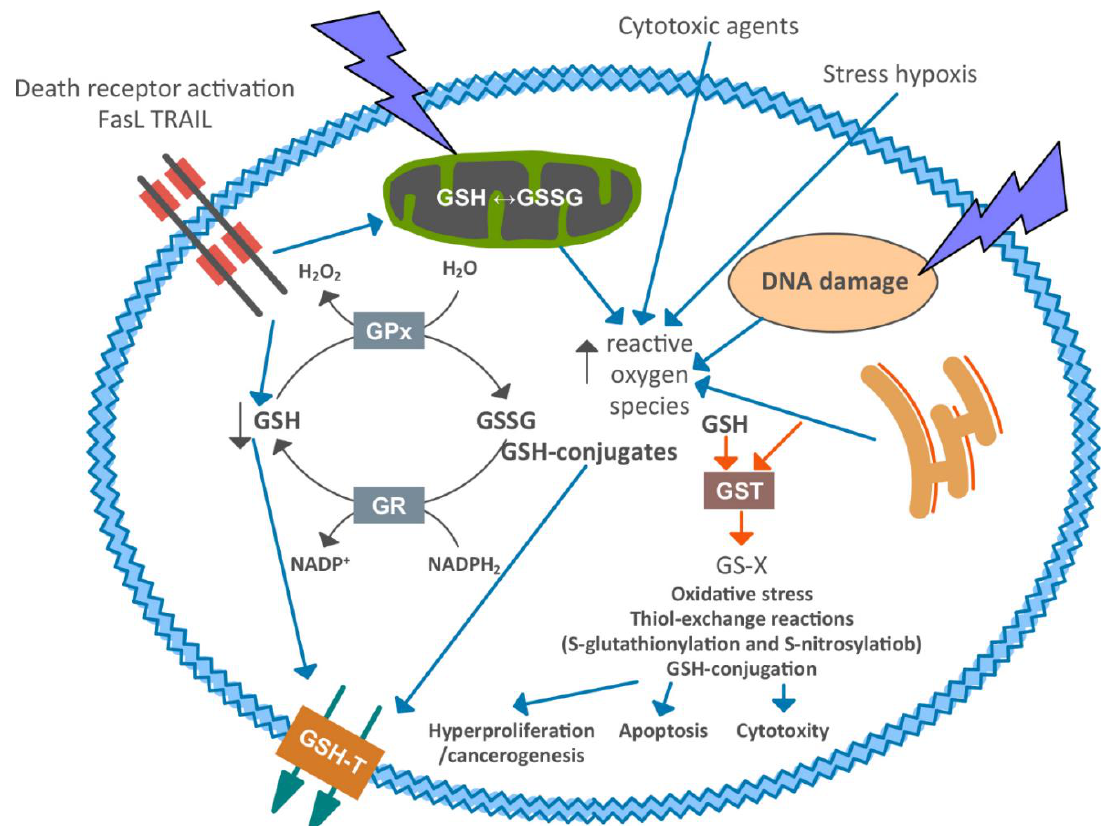
Figure 1. Schematic view of glutathione and its metabolism enzymes involvement in carcinogenesis [40,41] Legend: GSH — reduced glutathione; GSSG — glutathione disulfide; GРх— glutathione perox- idase; GSR — glutathione reductase; GST — glutathione transferase; GSH-T — glutathione trans- porter; GS- Х— glutathione electrophile conjugate.